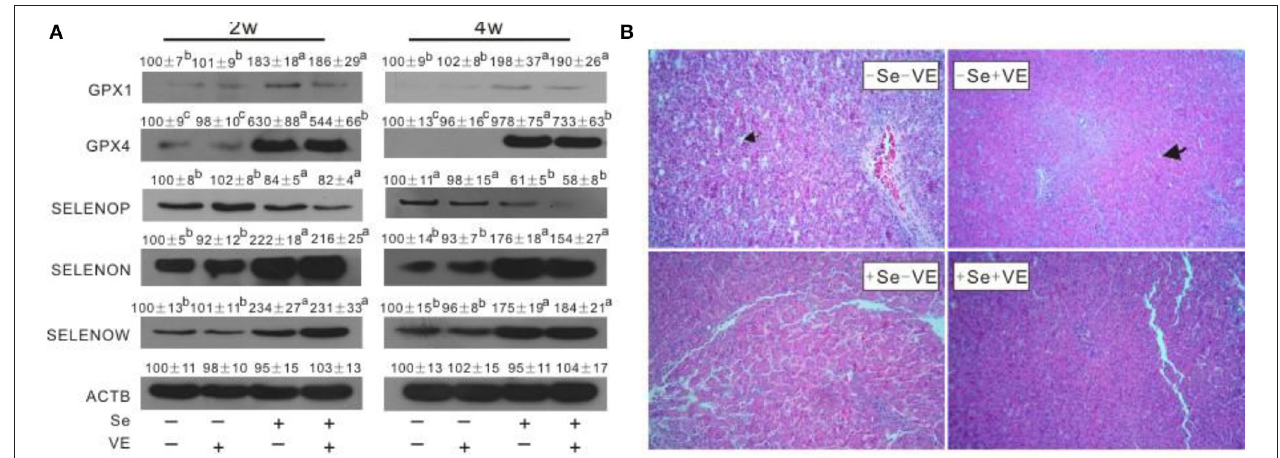
FIGURE 2 | Effects of dietary Se and VE on hepatic (A) protein levels of GPX1, GPX4, SELENOP, SELENON, and SELENOW in chick at weeks 2 and 4 and (B) histopathological changes in chick at week 4. The image (B) is representative of five sets of data. Original magnification 400 × . Data are means ± SE, n = 3. Values within a given gene differ ( P < 0.05) without sharing a common superscript letter.